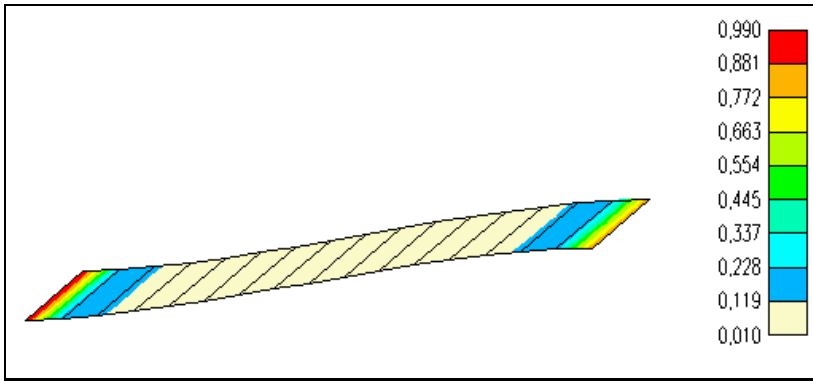
Figure 17. Damage contour plot in the deformed con fi guration of the PA66GF30 specimen.